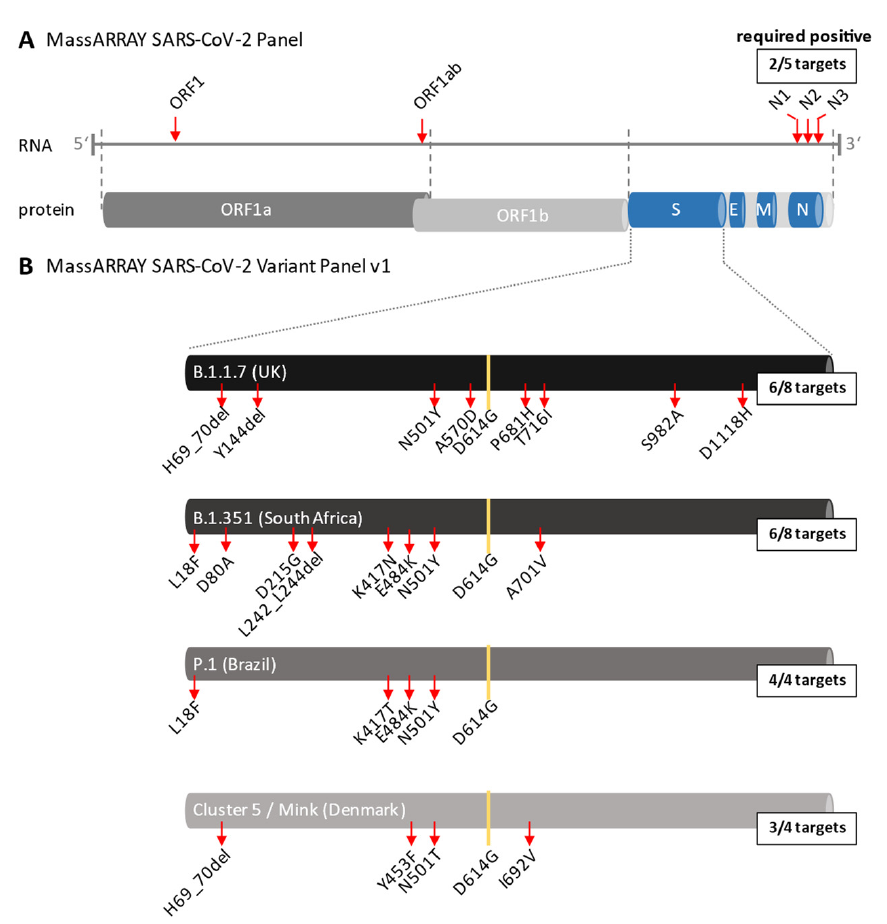
Figure 2. Genomic targets of the MassARRAY SARS-CoV-2 Panels . ( A ): The CE-IVD-certified MassARRAY SARS-CoV-2 Panel targets 5 genomic regions within the SARS-CoV-2 genome: ORF1, ORF1ab, N1, N2 and N3 (indicated by red arrows). The detection of at least 2 targets is required for the result “SARS-CoV-2 positive”. ORF, open reading frame; S, spike; E, envelope; M, membrane; N, nucleocapsid. ( B ): The MassARRAY SARS-CoV-2 Variant Panel v1 targets 20 specific mutations (indicated by red arrows) within the spike gene allowing the identification of 5 different SARS-CoV- 2 variants. For detection of the British (B.1.1.7) variant at least 6 out of the 8 mutations H69_70 del, Y144del, N501Y, A570D, P681H, T716I, S982A, D1118H are required while for detection of the South African (B.1.351) variant at least 6 out of the 8 mutations L18F, D80A, D215G, L242_L244del, K417N, E484K, N501Y and A701V are required. The 4 mutations L18F, K417T, E484K and N501Y identify the Brazilian (P.1) variant and the 4 mutations H69_70del, Y453F, N501T and I692V allow the identification of the Danish (Mink) variant (3 out of 4 mutations required). The mutation D614G evolved very early during the pandemic spread in 2020 and is present in all